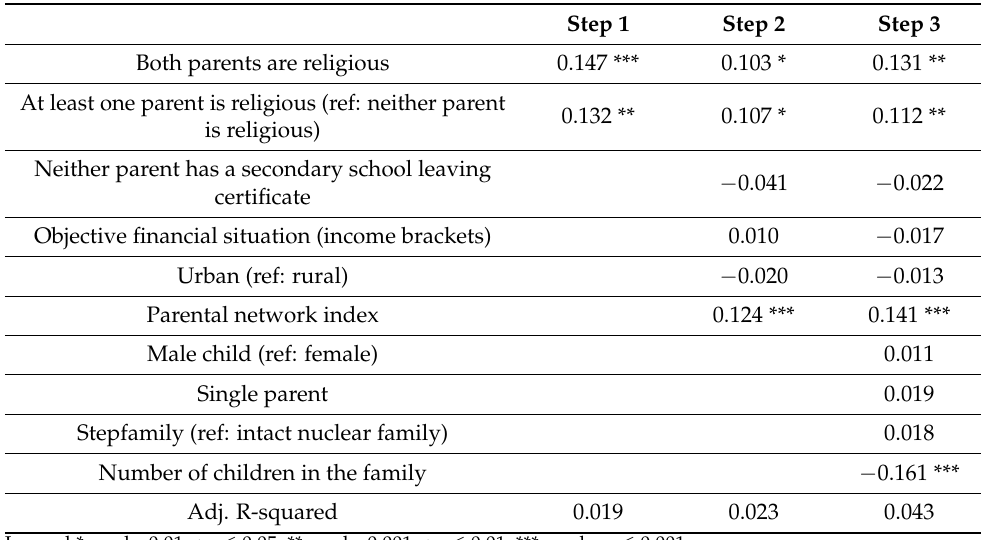
Table 1. Factors affecting the principal component of parental attention, multistage linear regression results (regression betas and the significance level of